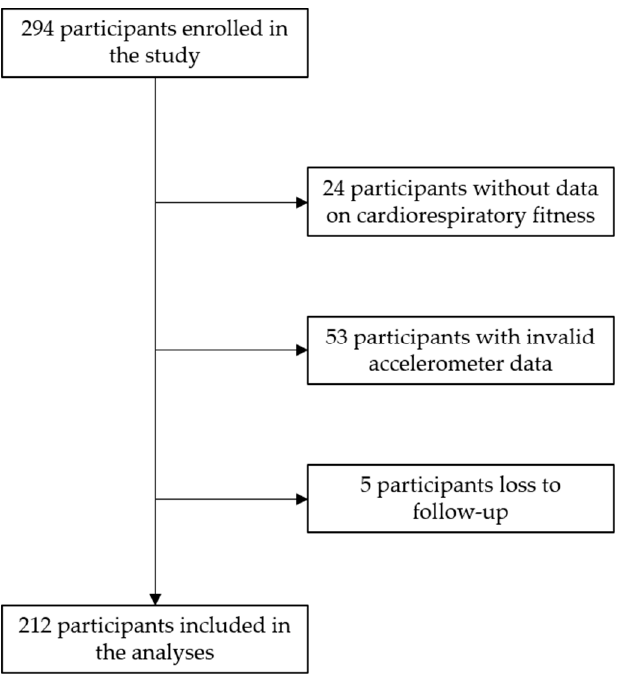
Figure 1. Flow diagram of the study sample.